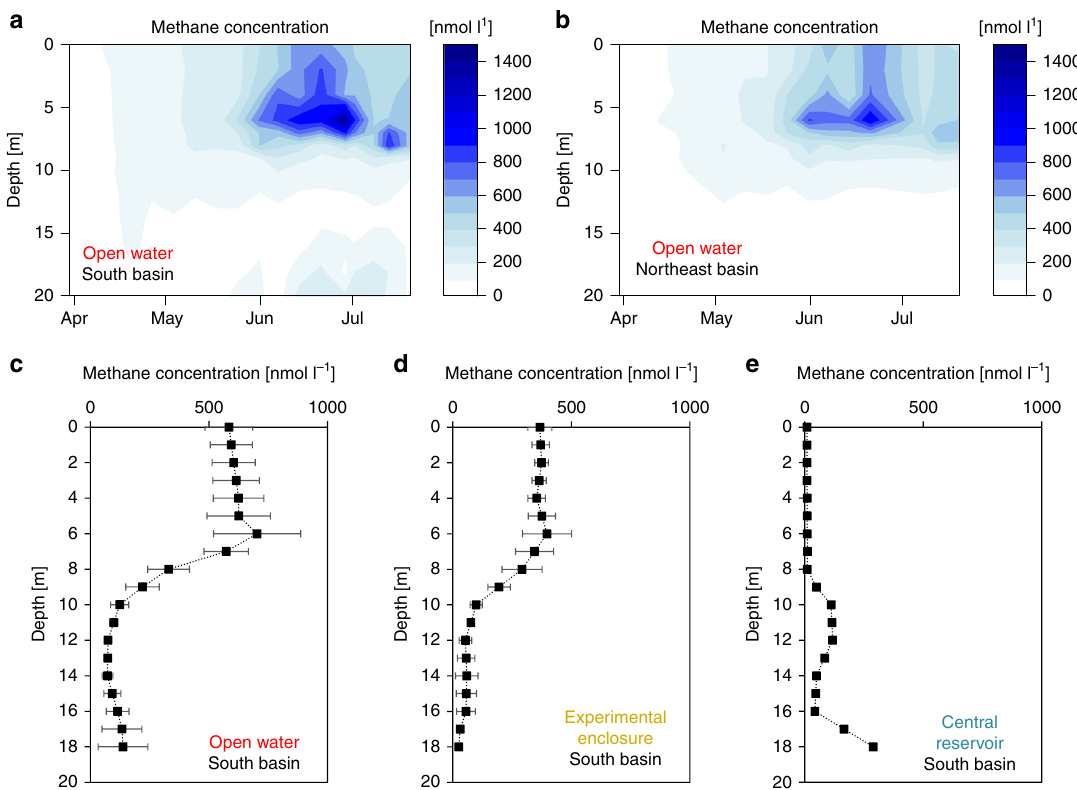
Fig. 2 Methane accumulation in the water column. Panel a shows the in situ methane concentration [nmol l − 1 ] recorded weekly in 2016 in the South basin (53°08'36.6''N 13°01'42.8''E). Increasing concentration indicates accumulation. Panel b shows the methane concentration [nmol l − 1 ] recorded weekly in 2016 in the Northeast basin (53°09'20.2''N 13°01'51.5''E). Note, panel a contains an additional data point compared to panel b in the end of June. Panel c shows the methane pro fi le in the open lake of the South basin (53°08'36.6''N 13°01'42.8''E; 20.5 m deep) as mean ± SD of 4 pro fi les taken on 4 different days in August 2014. Panel d shows the methane pro fi le inside experimental enclosure 1 (53°08'36.4''N 13°01'41.6''E; ca. 20 m deep) as mean ± SD of 4 pro fi les taken on 4 different days in August 2014. Panel e illustrates the methane pro fi le inside the central enclosure (53°08'35.8''N 13°01'41.1''E; ca. 18.5 m deep) as mean ± SD of methodological duplicate measurement taken on 7 th July 2016. Source data are provided as a Source Data fi